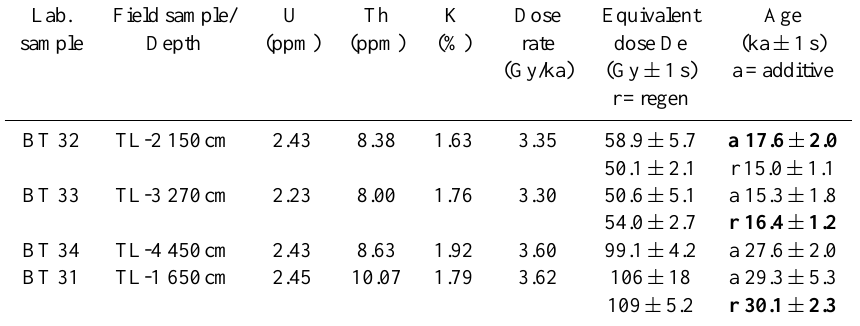
Table 1. IRSL dating results. Lab. Field sample/ U Th K Dose Equivalent Age sample Depth (ppm) (ppm) (%) rate dose De (ka ± 1s) BT 32 TL-2